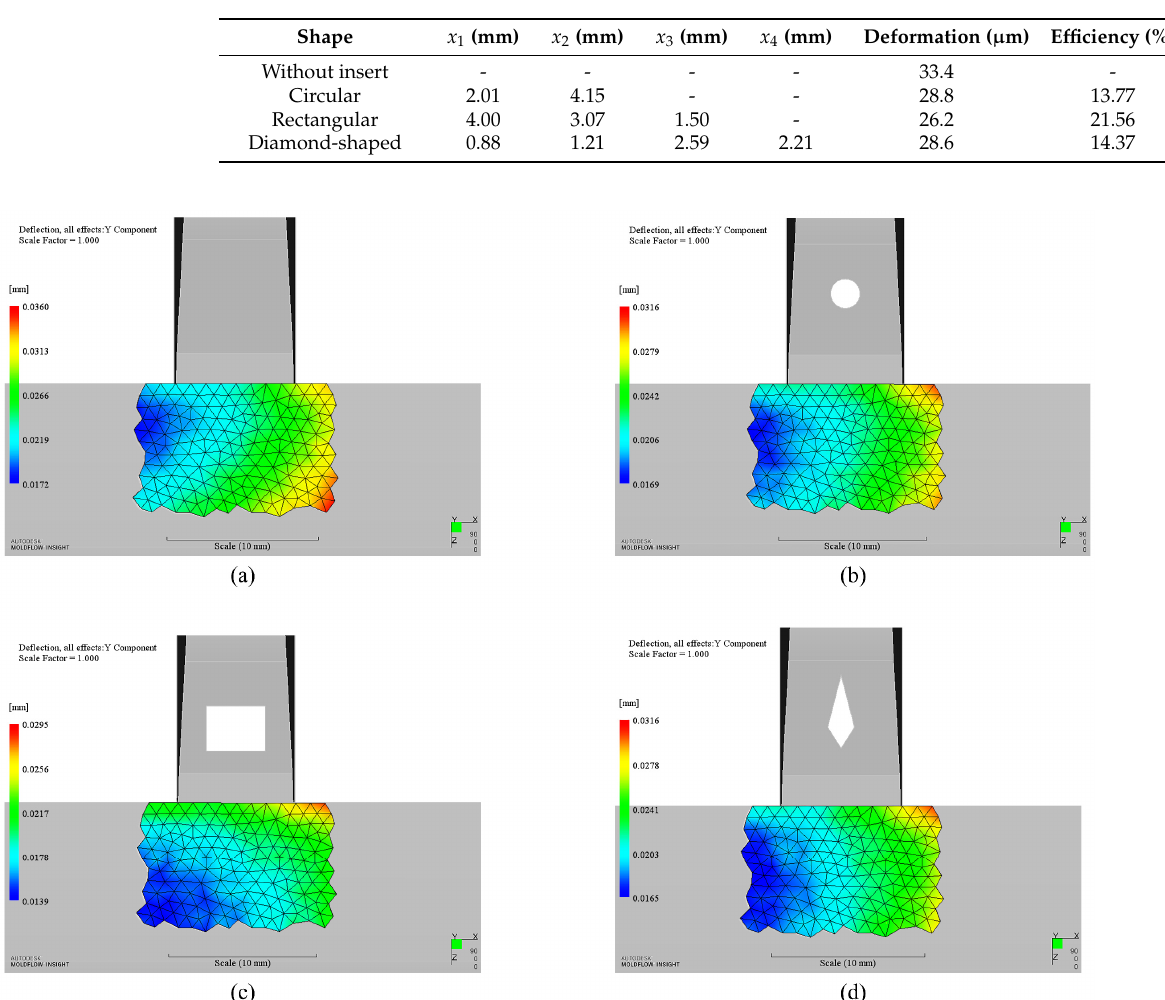
Table 4. Optimized results of different shape inserts.